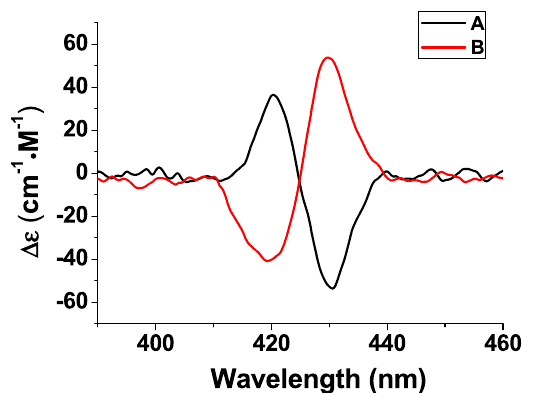
Figure 2. Circular dichroism spectra of a solution of [Zn 3 -BTATPP] (1.3 × 10 − 6 M) and 5.5 × 10 − 7 M of ( A ) S − 1-(1-naphthyl)ethanol ( 2S ), or ( B ) R-1-(1-naphthyl)ethanol ( 2R ) in the mixture of hexane and methylene chloride (9:1) at 295